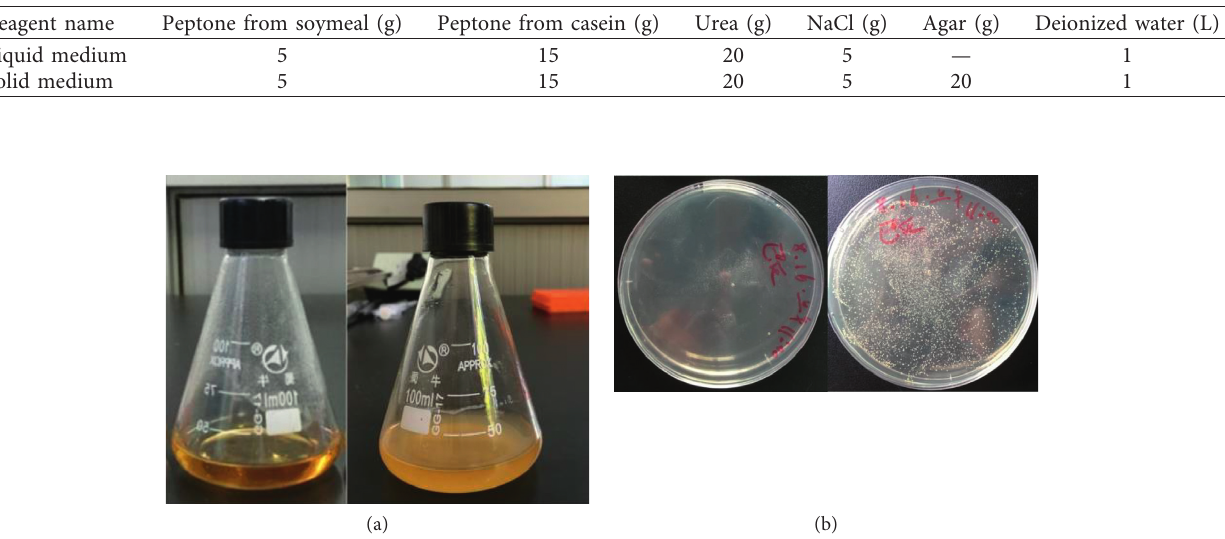
Table 1: CASO medium components.